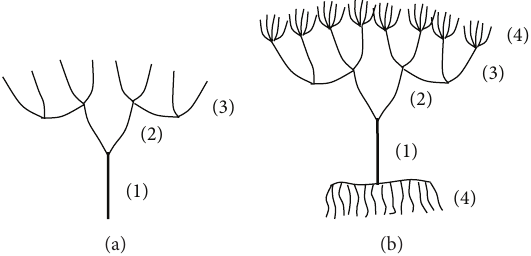
Figure 2: Tree-shaped model of the biomimic fabric, (a) original biomimic fabric with three hierarchies and (b) fuzzy biomimic fabric with four hierarchies: (1) trunk of the tree; (2) main branch of the tree; (3) slim branch of the tree; (4) leaves and roots of the tree.